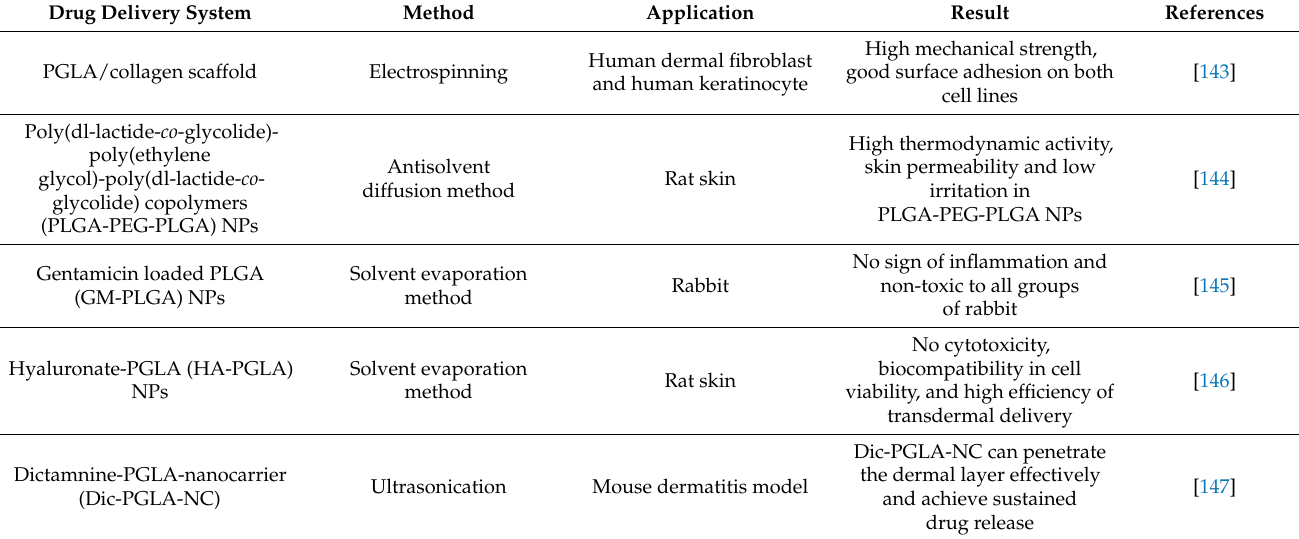
Table 2. Recent study of PLGA in transdermal drug